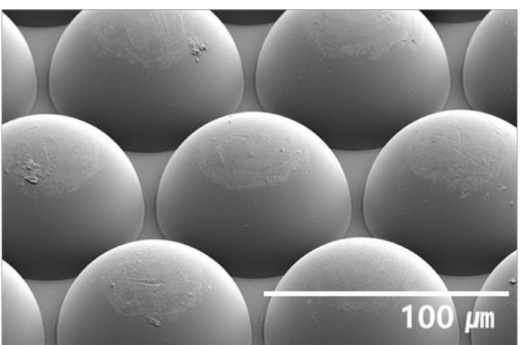
Figure 3. A 45 ◦ tilted SEM image of hexagonally packed hemisphere MLA for light extraction layer.